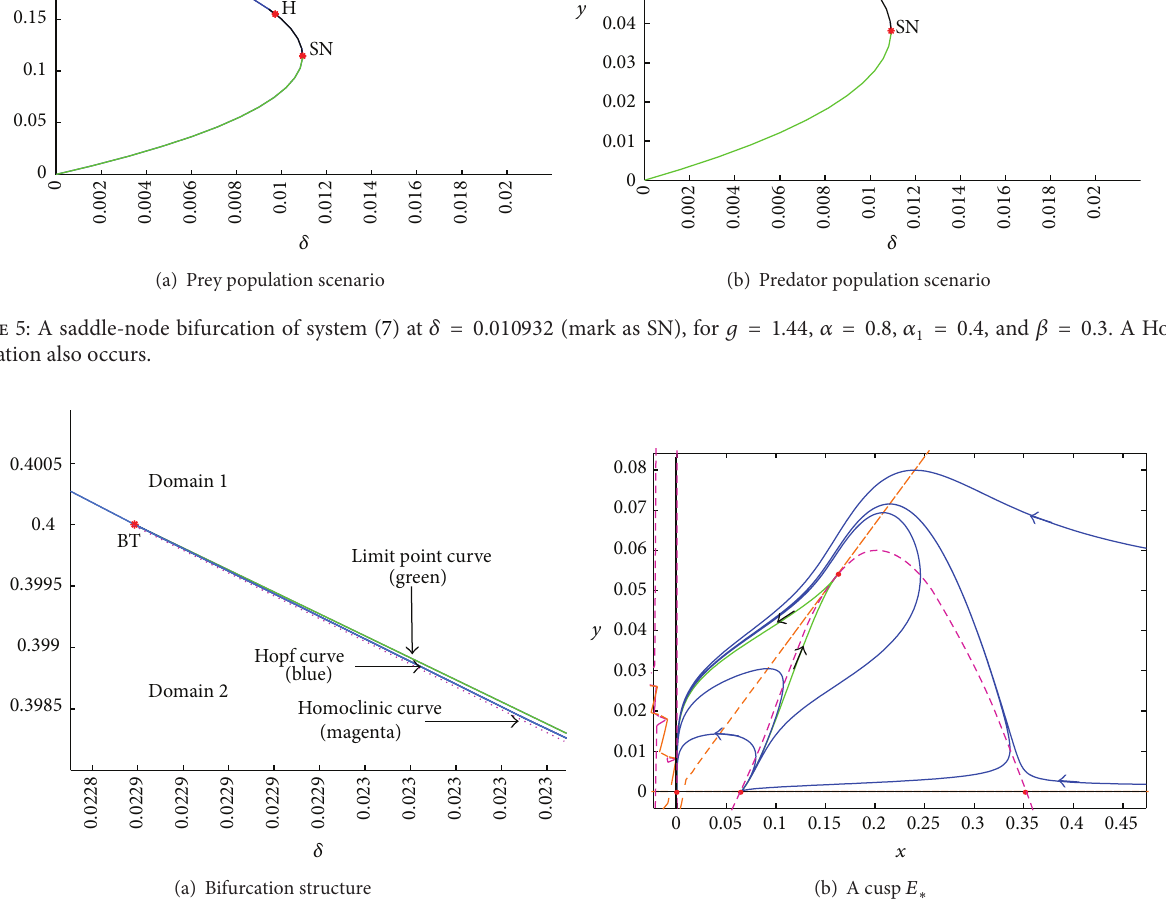
Figure 6: Bifurcation structure of system (7) in (𝛿,𝛼 1 ) with a Bogdanov-Takens bifurcation and phase portraits for 𝑔 = 1.44 , 𝛿 = 0.022859 , = 0.4 , and 𝛽 = 0.3 𝛼 = 0.4 , 𝛼 1